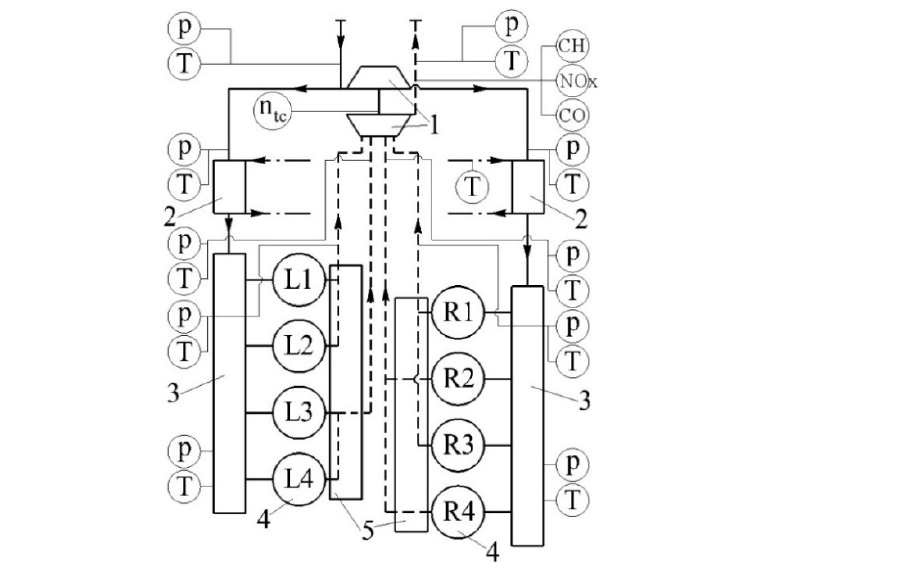
Figure 2. Diagram of the main elements of the diesel engine and the locations of measuring sensors: 1—turbocharger; 2—charge air cooler; 3—intake manifold; 4—cylinder head; 5—exhaust manifold; T—temperature sensor; p—pressure sensor; n tc —turbocharger rotor speed sensor; NOx, CO, CH— sensors for the concentration of harmful substances in the exhaust gases; L1…L4—cylinder numbers of the left block; R1…R4—right block cylinder numbers. Note: Solid lines show the direction of air movement, dotted lines show the direction of movement of the exhaust gases and dash-dot lines show the direction of movement of the coolant.